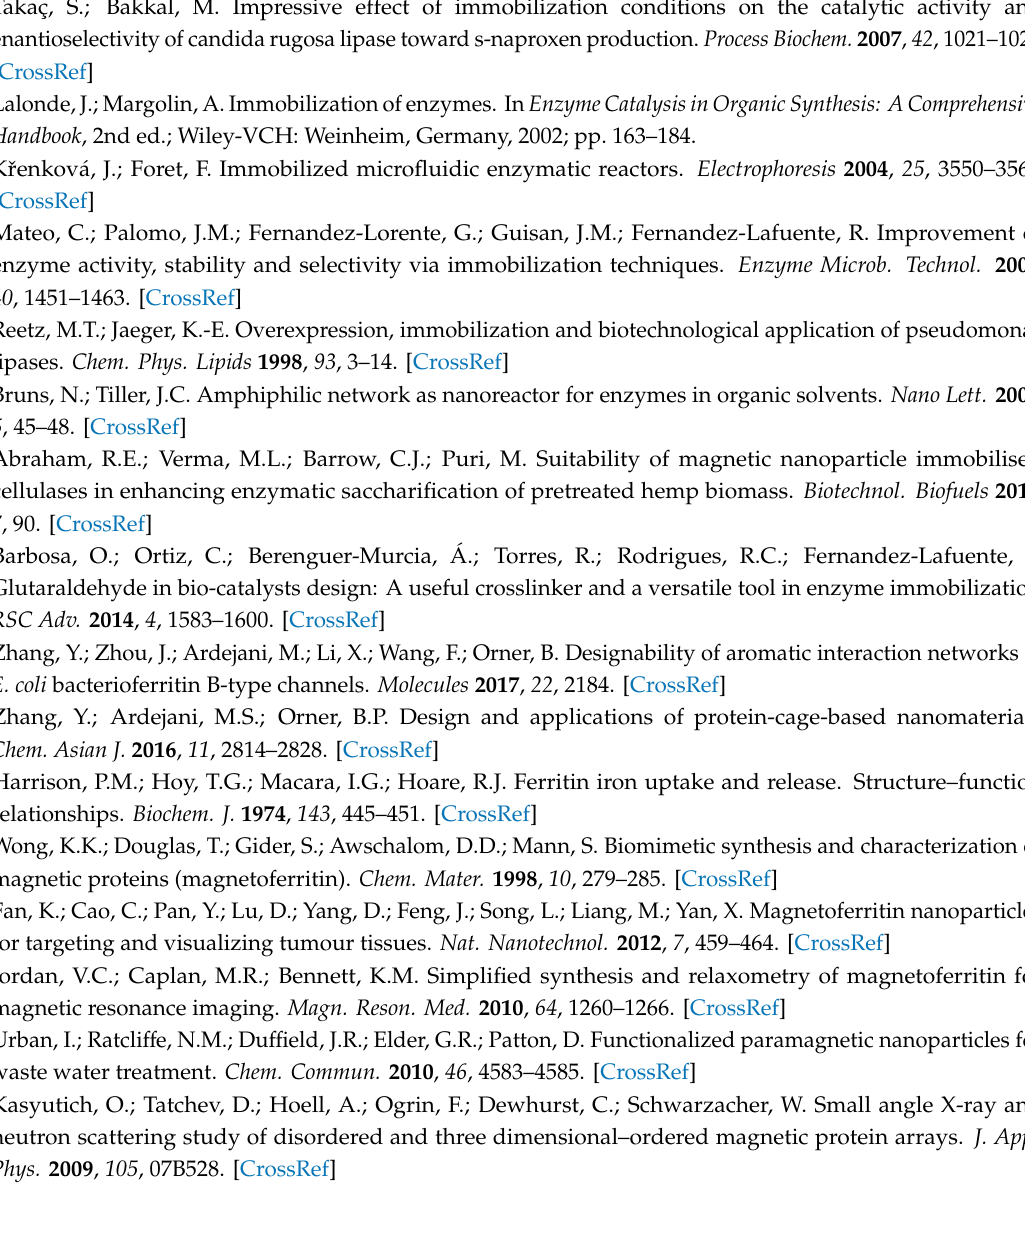
Table S1: DNA primers used for the construction of the HE and KG protein, Figure S1: Standard curve of p -nitrophenyl, Figure S2: SDS-PAGE analyses, Figure S3: (A) Magnetoferritin purified by SDG. (B) UV absorbance of the sample after sucrose density gradient ultracentrifugation separation, Figure S4: Raman spectroscopy of magnetoferritin of